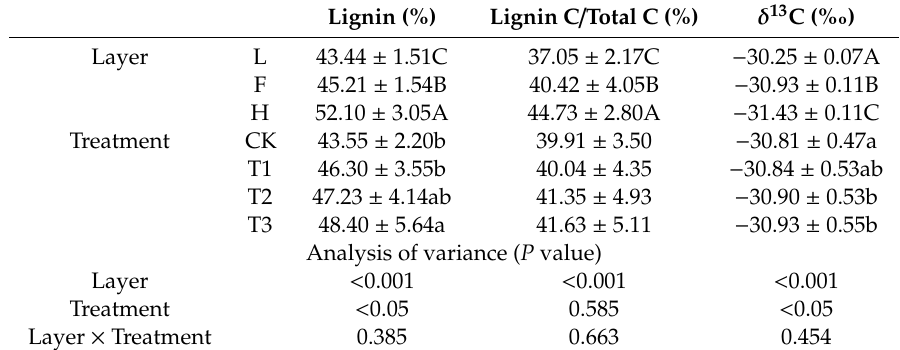
Table 2. E ff ects of simulated acid rain (SAR) treatment and litter residue decomposition layer on δ 13 C value, lignin fraction concentration, and proportion of lignin fraction C to the total C (Lignin C / Total C).